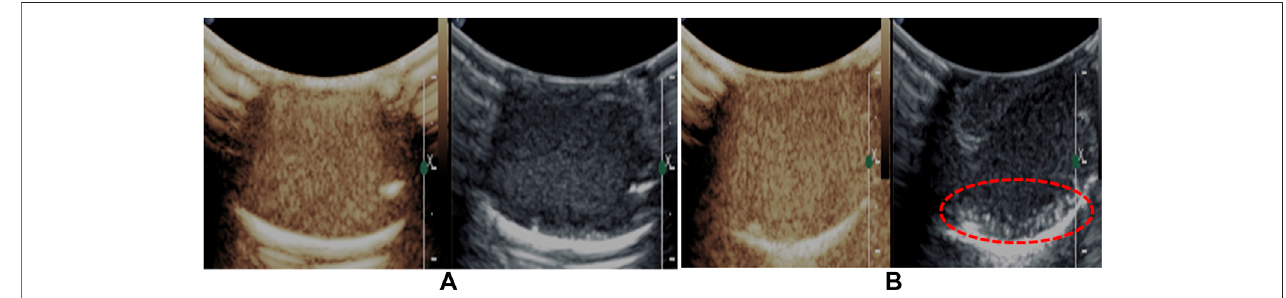
Figure 8 | Representative in vitro ultrasonic images. (A) Precrush and (B) postcrush of the nanobubbles upon high-frequency ultrasound exposure.